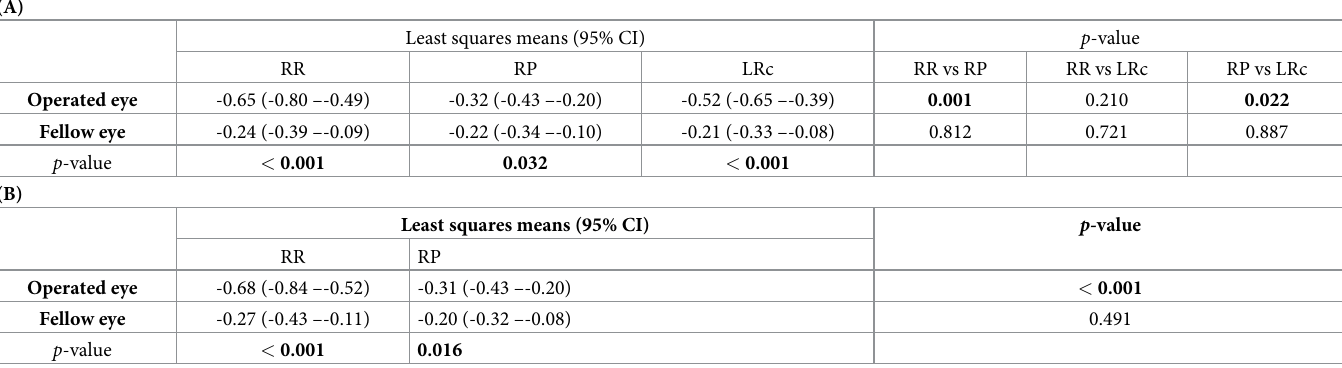
Table 4. Differences in postoperative astigmatism according to the type of strabismus surgery (A) in the total patients and (B) in the patients whose deviation angel was ≧ 20 PD and < 40 PD.